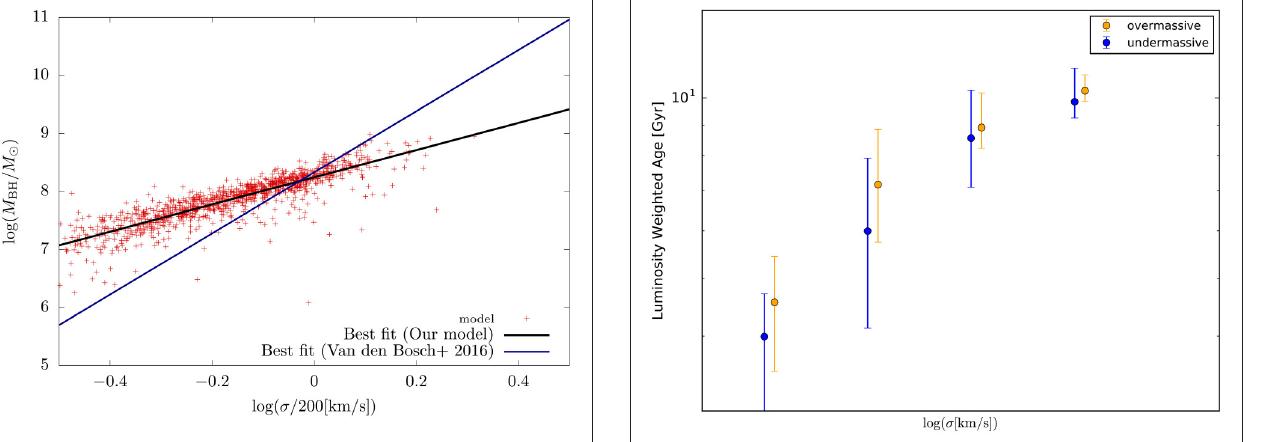
FIGURE 3 | σ − age relation with the fiducial model. The age is luminosity weighted. Orange and blue points with errorbars show the median values of over-/under- massive BH galaxies with 1 − σ error.